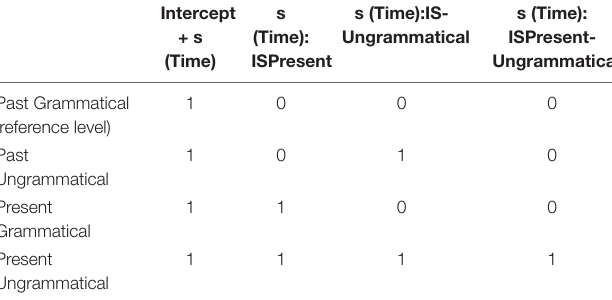
TABLE 2 | Fixed-effects model terms and how they relate to each